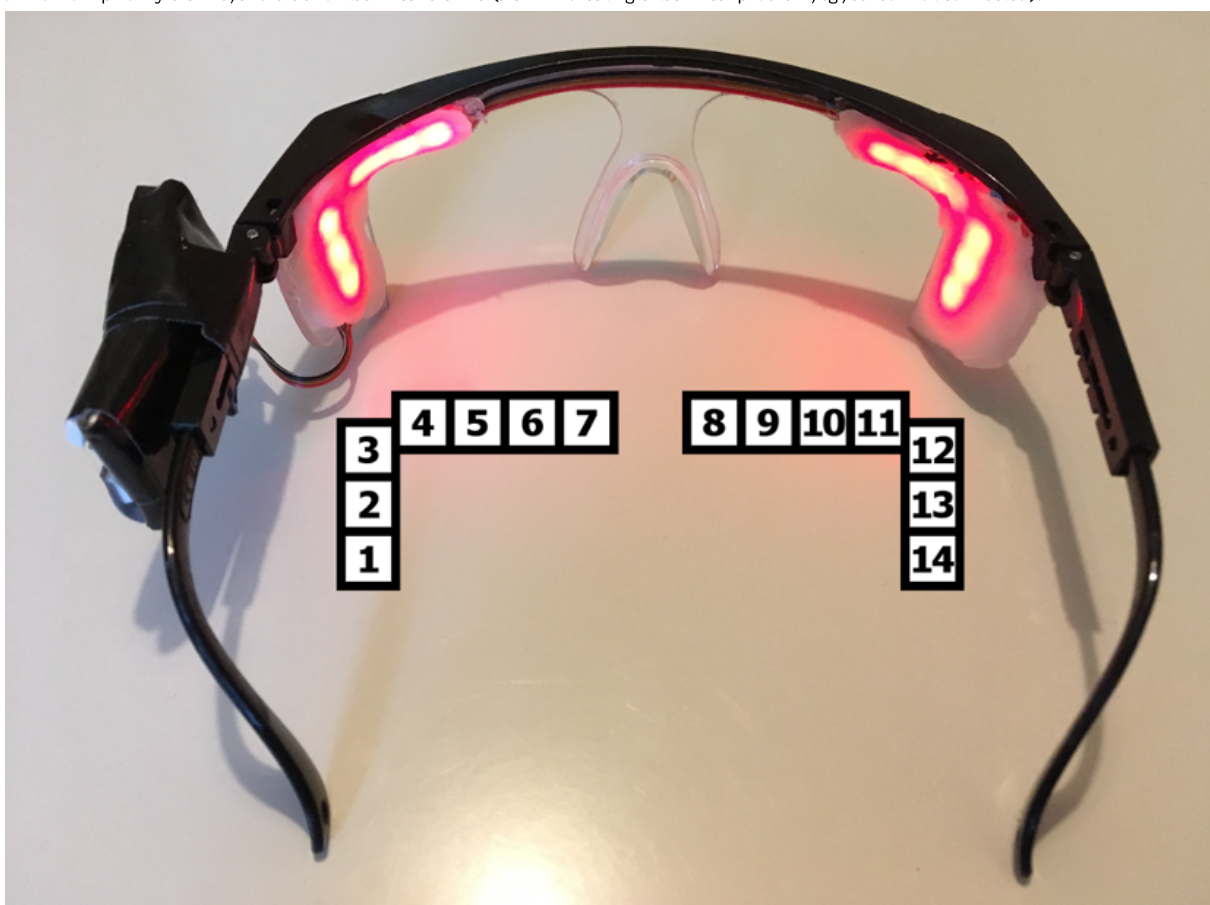
Figure 20. Cobus and Heuten’s [26] head-mounted displays displaying a high-priority alarm. All light-emitting diodes (LEDs) were activated simultaneously for the alarms. The peripheral light followed the alarm colors commonly used by patient monitors. Red was used for high-priority alarms, yellow for low-priority alarms, and blue for technical alarms (alarm indicating a technical problem, eg, sensor not connected).